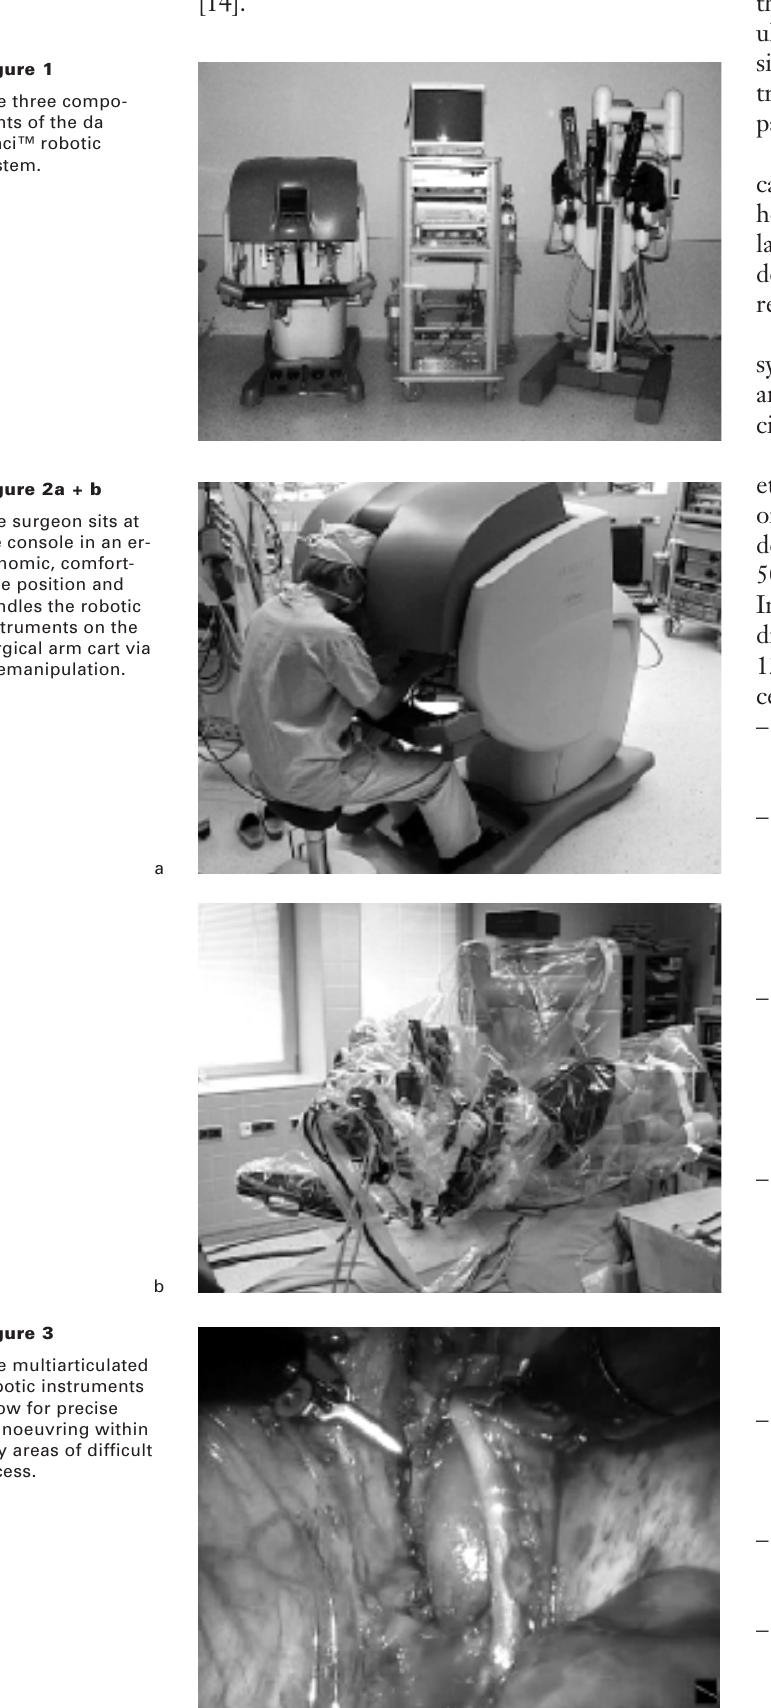
The three compo- nents of the da Vinci™ robotic system.